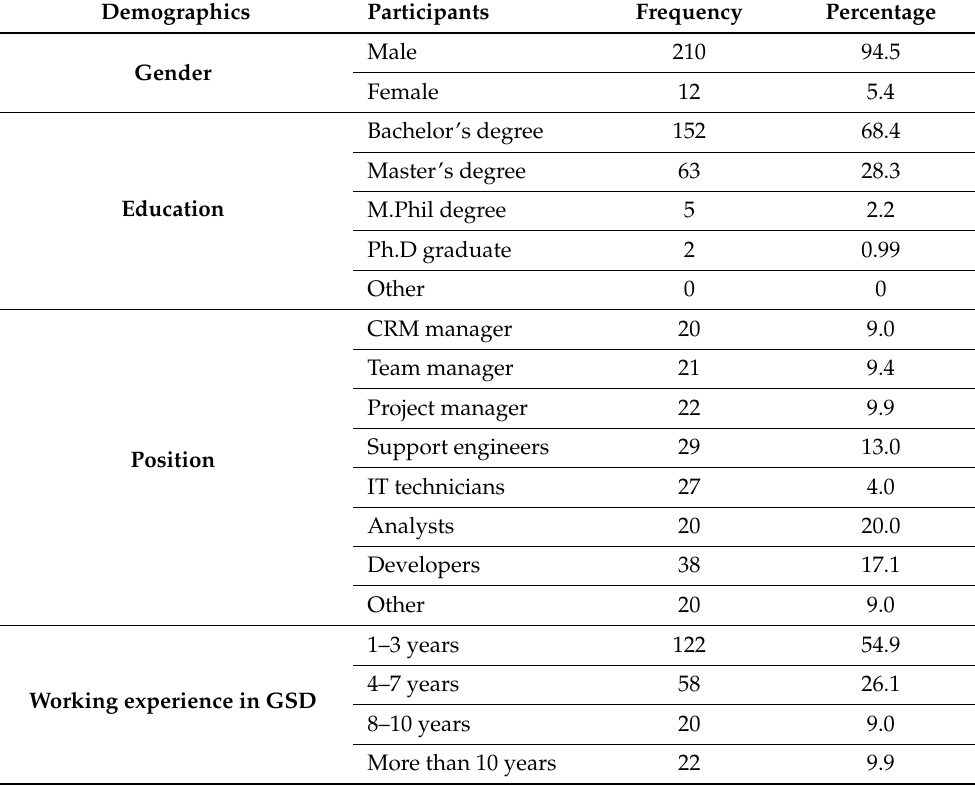
Table 4. Summary of participants